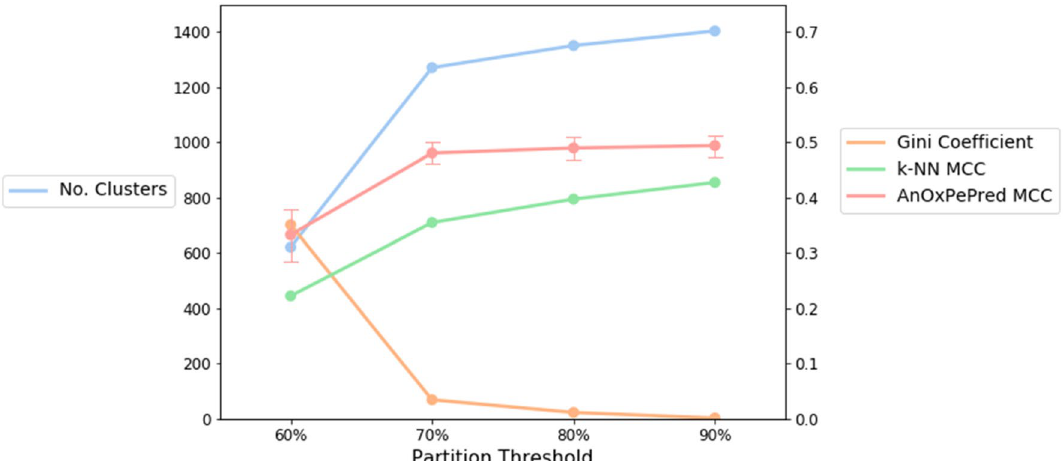
Figure 4. Overview of the effects of partitioning the data with different thresholds. Plotted is the performance of AnOxPePred and k-NN represented by the MCC of FRS, number of clusters (i.e. the number of groups of peptides based on the specified threshold) and the Gini coefficient based on the distribution of FRS peptides in each fold. MCC Matthew’s correlation coefficient, FRS free radical scavenger.